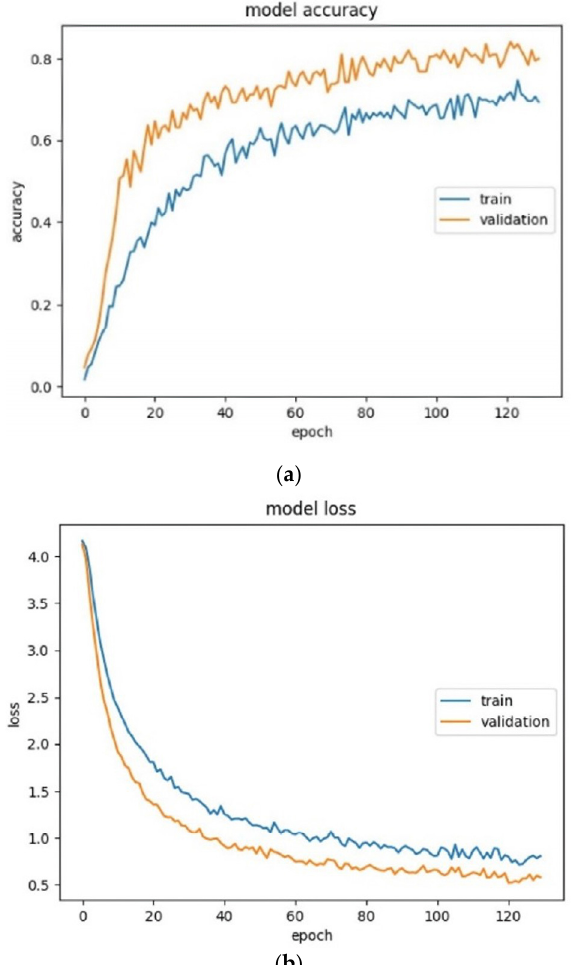
Figure 7. ( a ) Accuracy of the training and validation data; ( b ) Model loss of the training and validation data.